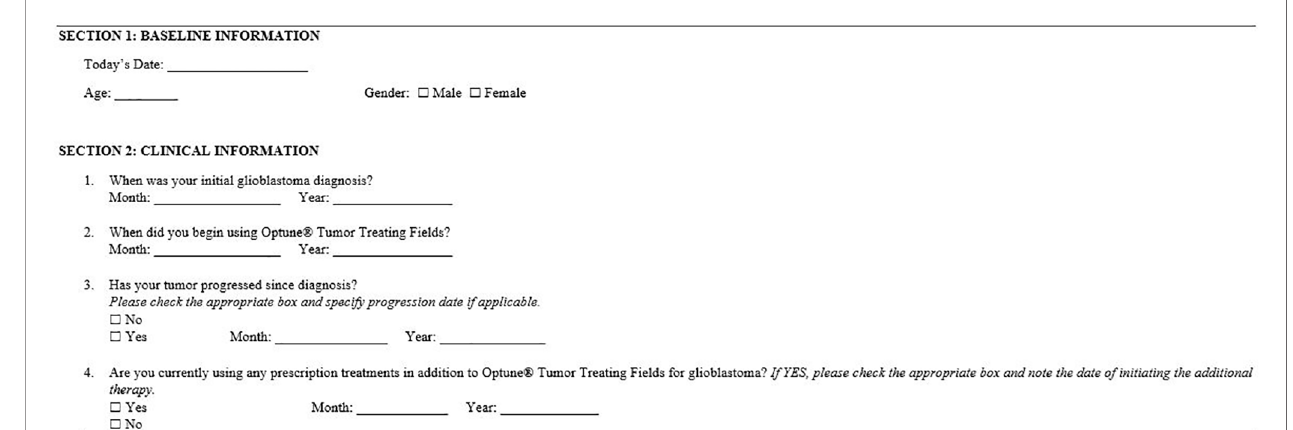
FIGURE 1 | Survey of baseline demographic and clinical information. All items included in the survey were self-reported by respondents. Respondents also received their country-speci fi c EuroQol ’ s EQ-5D-5L questionnaire and EuroQol ’ s visual analogue scale